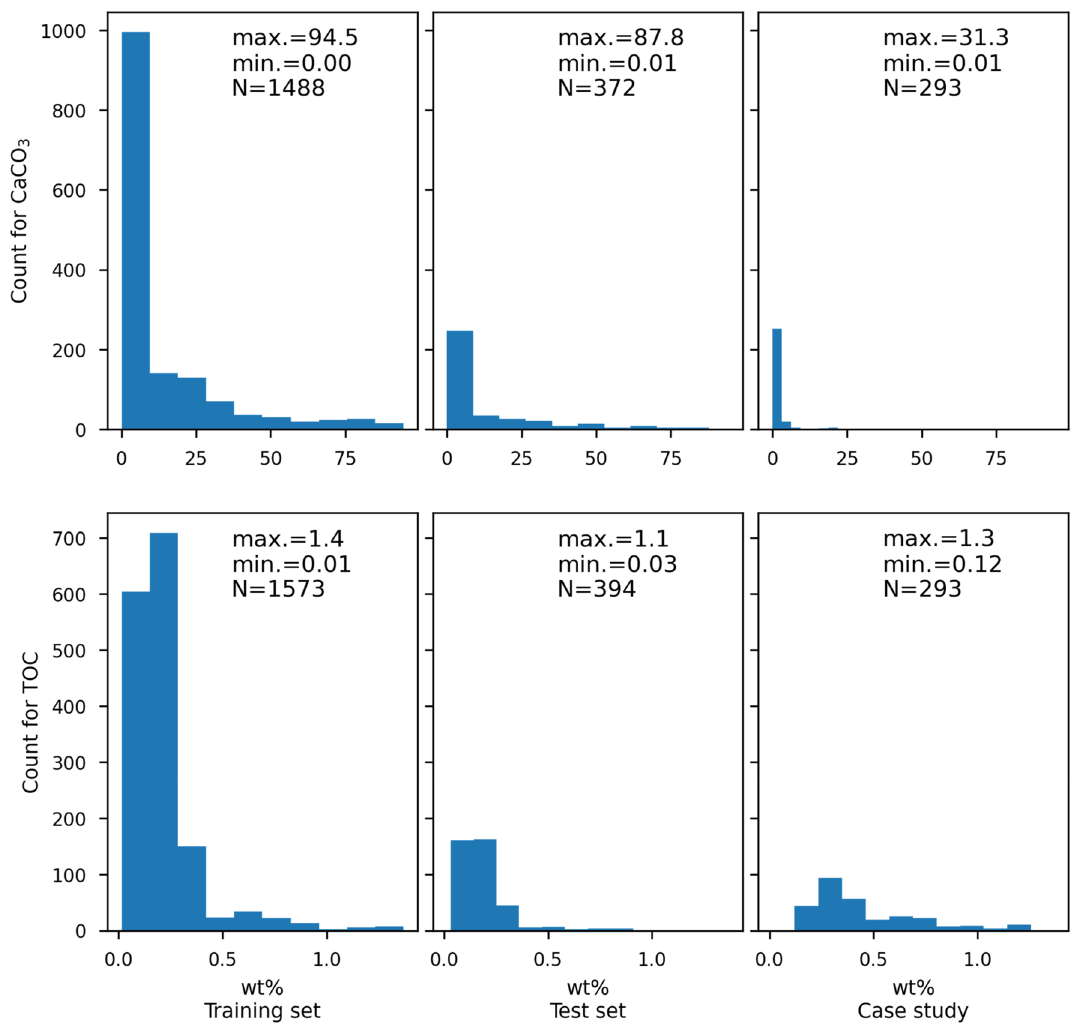
Figure 3. Data distributions of CaCO 3 and TOC for the training set, test set and case study.